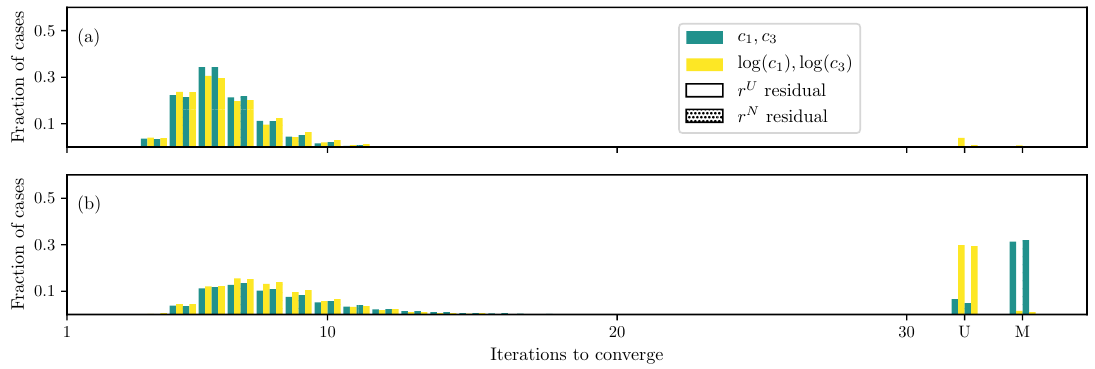
Figure 5. Iterations required using different formulations for the Humphrey model (4) FC case when ( a ) all parameters except the fiber angle θ are unknown and ( b ) all parameters are